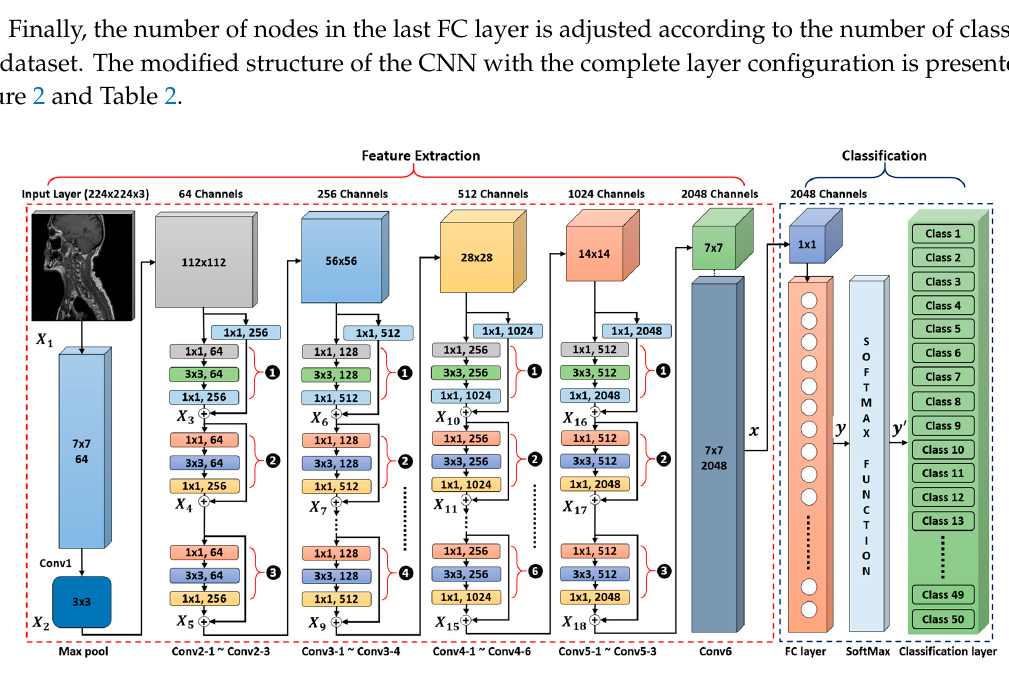
Figure 2. Overview of the proposed deep convolutional neural network (CNN) architecture used for feature extraction and classification.